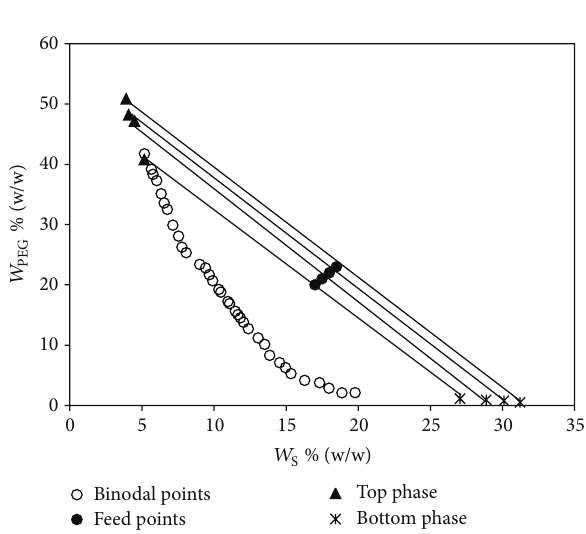
Figure3:BinodalcurveandtielinesforPEG6000( 𝑊 ) + water system at succinate ( 𝑊 S